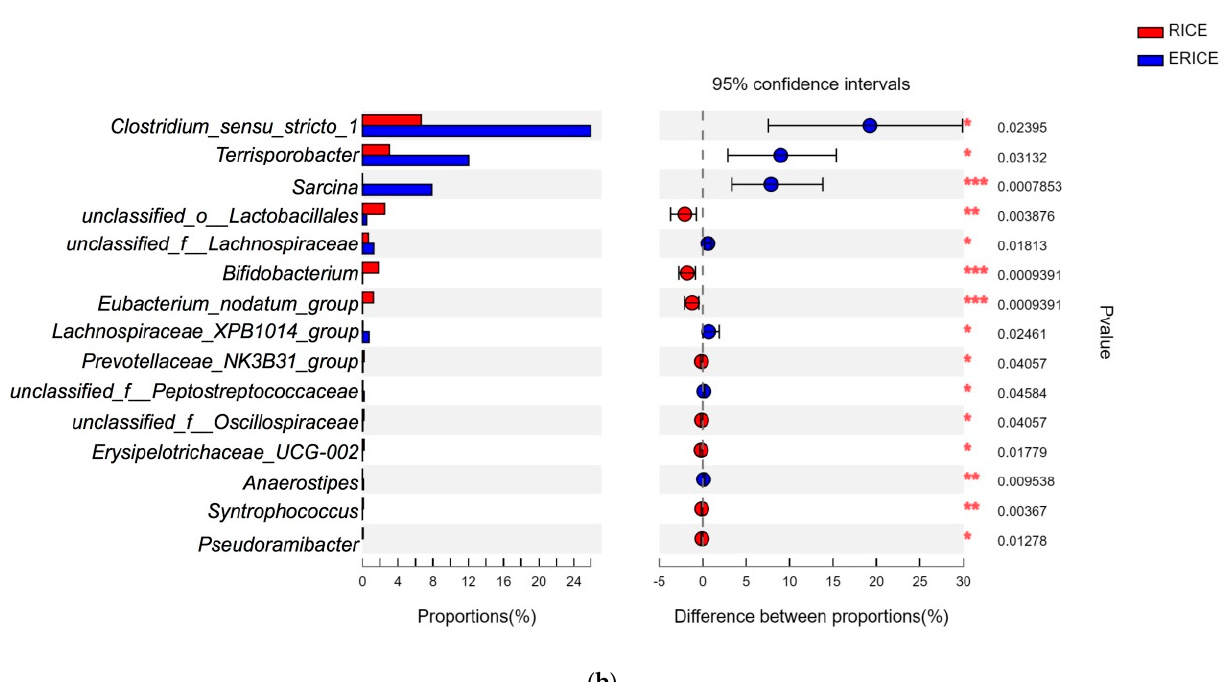
Figure 7. Differential abundance of bacteria between CORN and ECORN ( a ) and between RICE and ERICE ( b ). Treatments were corn as the main cereal type (CORN), or half of the corn replaced by extruded corn (ECORN), broken rice (RICE), and extruded broken rice (ERICE), respectively. * p < 0.05; ** p < 0.01; *** p < 0.001. n = 8.